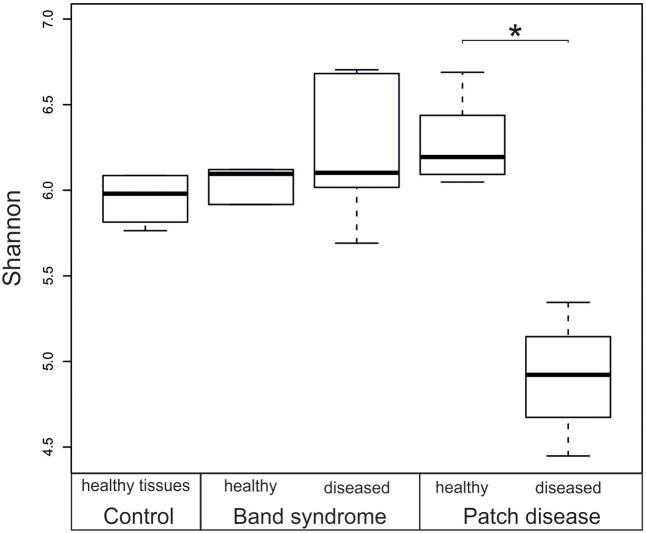
Box plot showing the diversity (Shannon index) based on 16S rRNA sequences from healthy and diseased N. mamillare tissues. The mean value and the standard deviation are represented by a line and a box respectively, and minimum and maximum values are represented by whiskers. ∗p < 0.05.